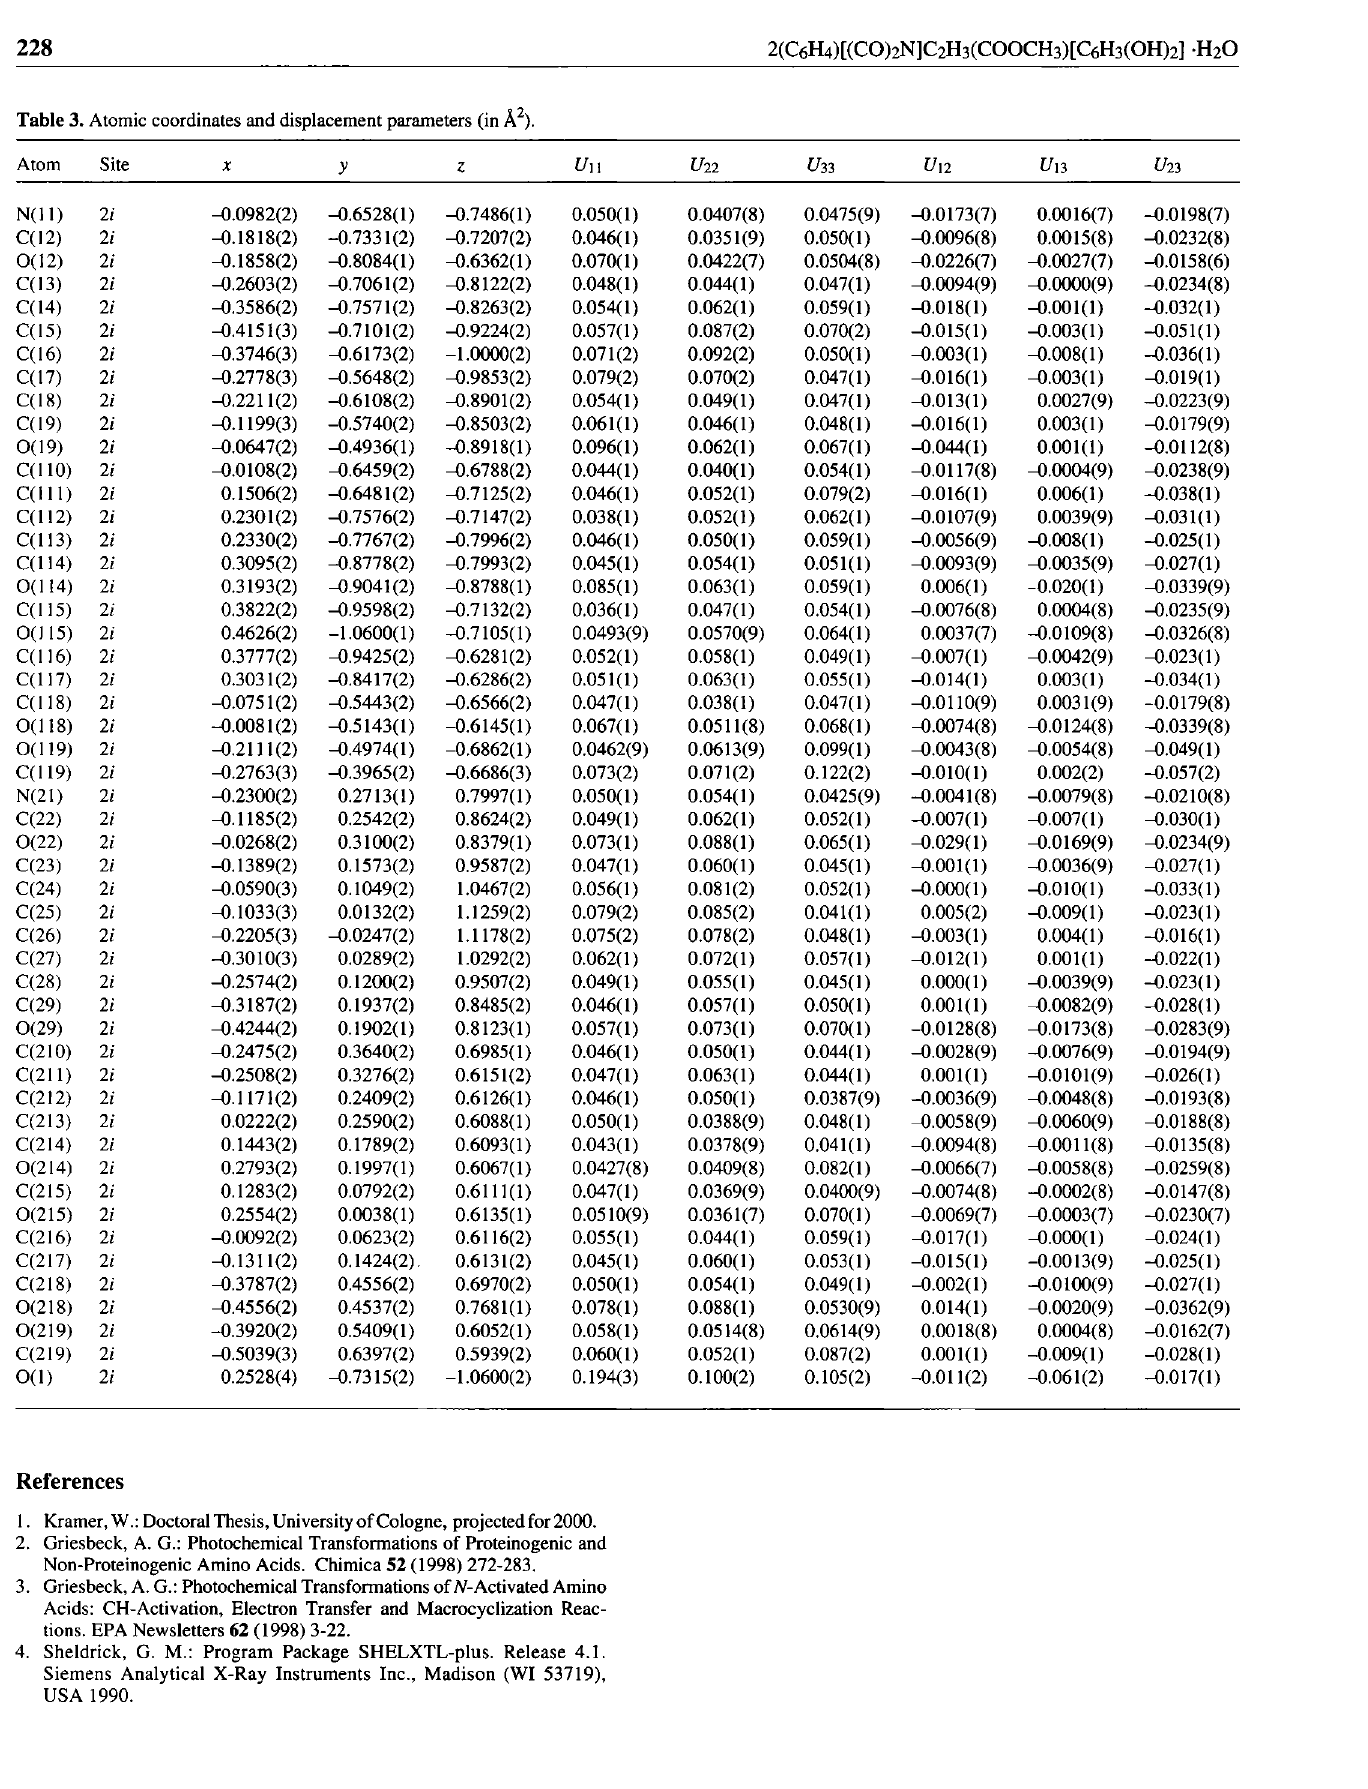
Table 3. Atomic coordinates and displacement parameters (in Ä 2